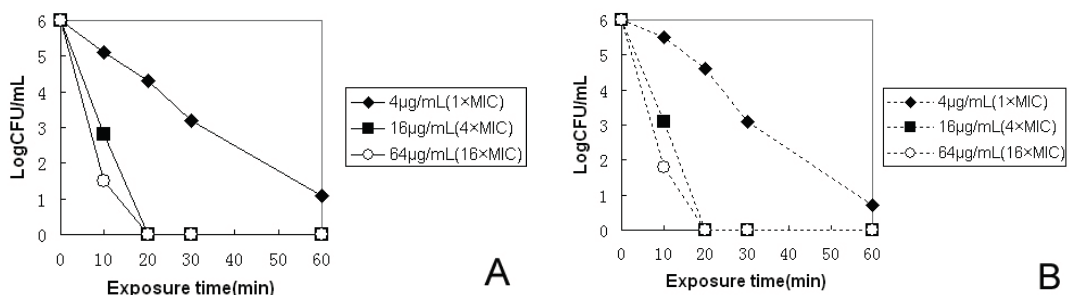
Figure 1. Bactericidal kinetics study. The bactericidal activity of pexiganan ( A ) and PNPs ( B ) against H. pylori were monitored for the first 1 h. After 0, 10, 20, and 60 min of exposure time at 37 °C, aliquots were diluted (serial 10-fold dilutions) and plated for CFU counts after 72 h incubation at 37 °C.